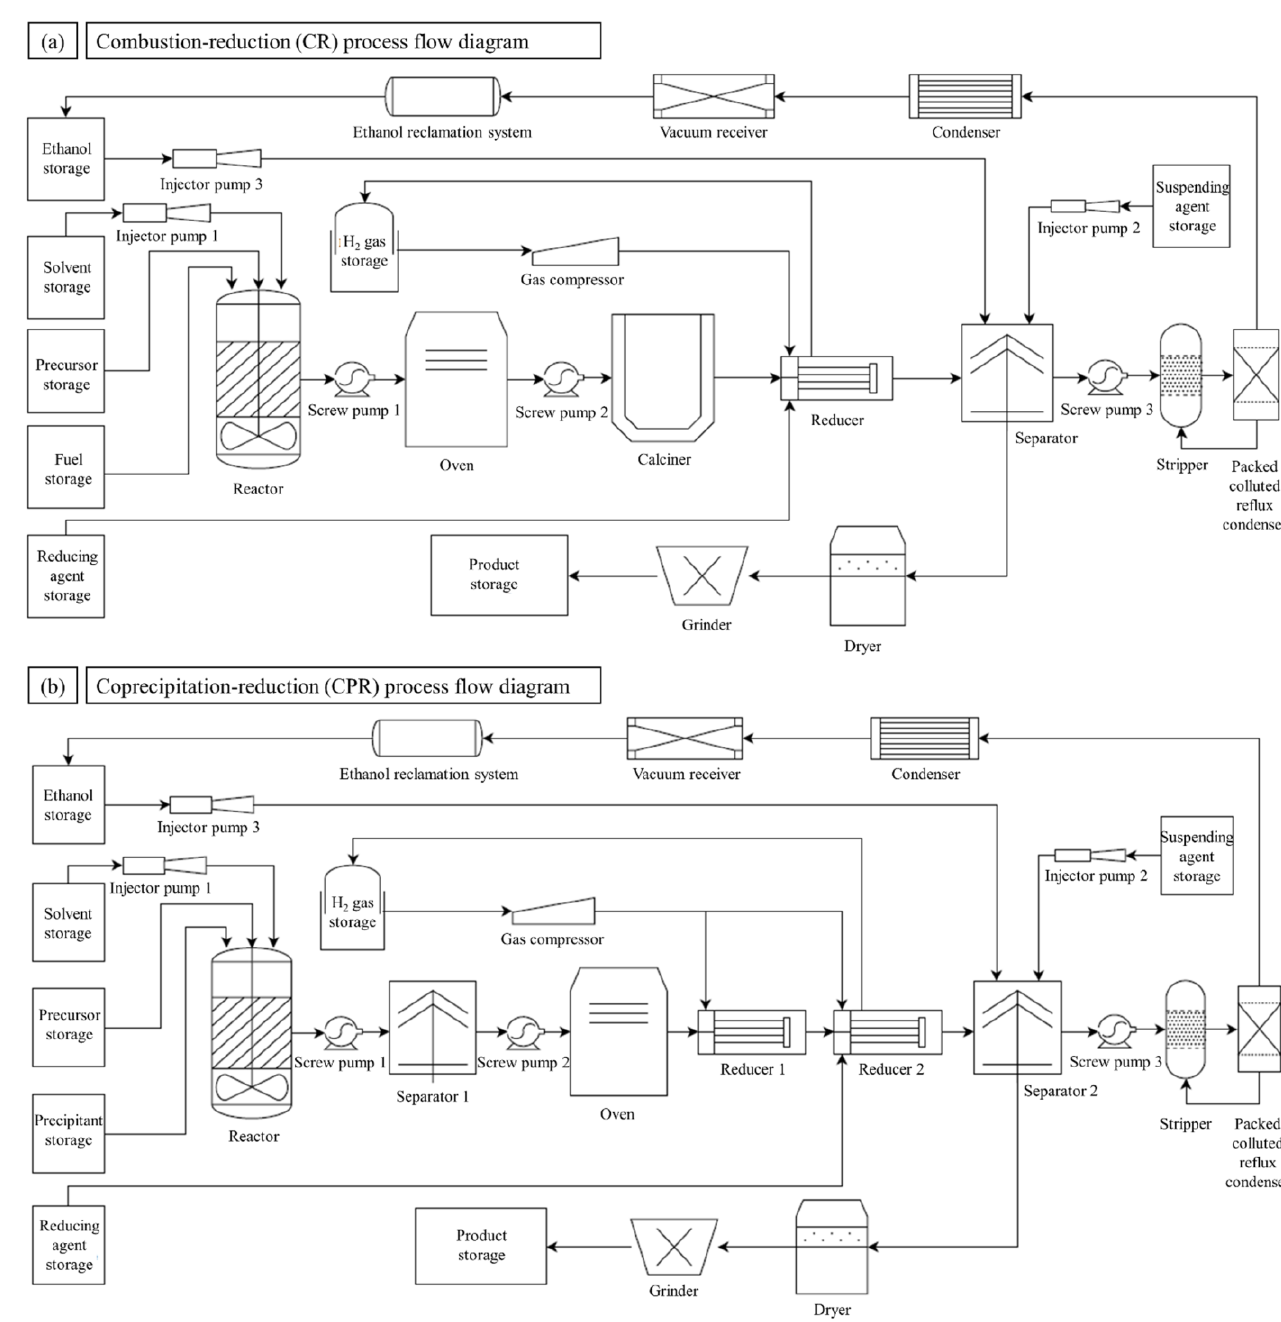
Fig. 1. Engineering process design in the large-scale production of LaNi 5 materials via (a) combustion-reduction (CR) and (b) co-precipitation-reduction